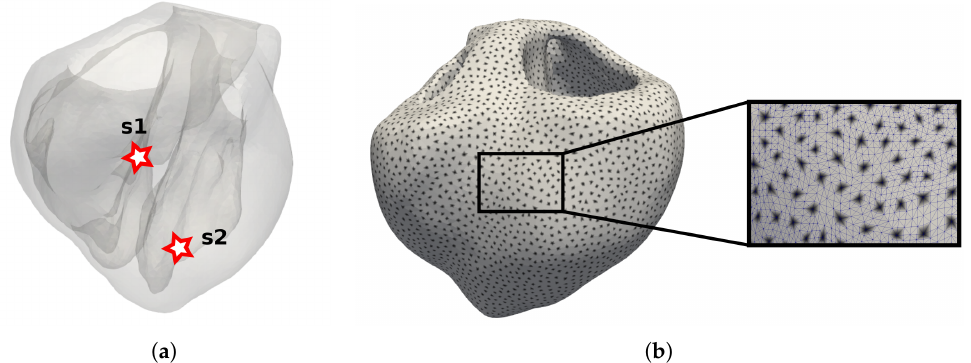
Figure 2. ( a ) Location of the S1 and S2 stimuli for the different electrophysiological models used in this study. ( b ) Finite element nodes extracted to approximate the probability distribution function (PDF) of action potential duration (APD). The inset provides the distribution of the extracted nodes within the spatial mesh